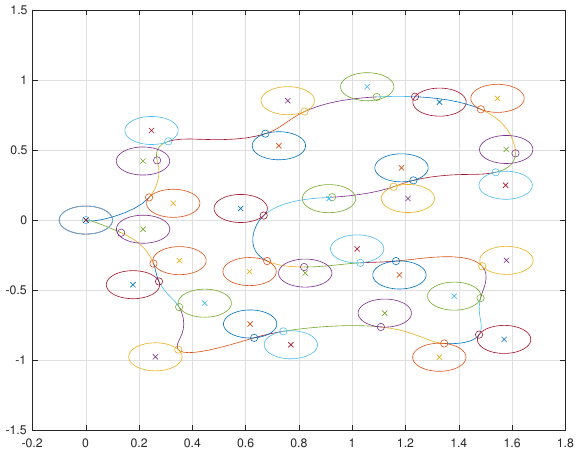
Figure 38. Trajectory of a single agent visiting 30 neighborhoods. The circles with an X in their center represent the neighborhoods and the circles along the vehicle’s trajectory represent the points at which the vehicle makes its